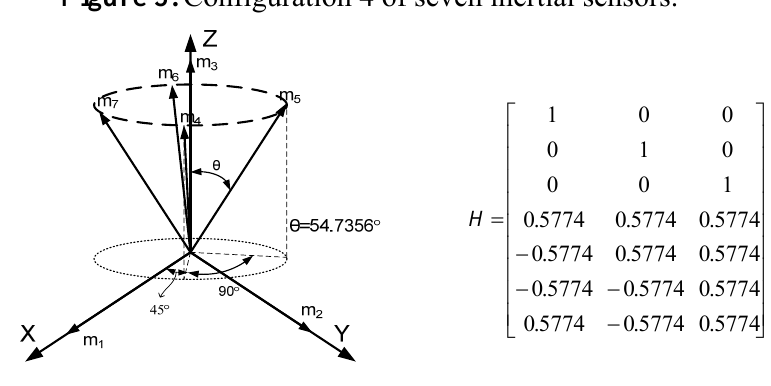
Figure 5. Configuration 4 of seven inertial sensors.